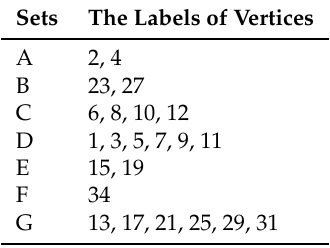
Table 2. The vertex labels of Γ ( Z p 2 × Z q 2 ) , for p = 3 and q = 2. Sets The Labels of